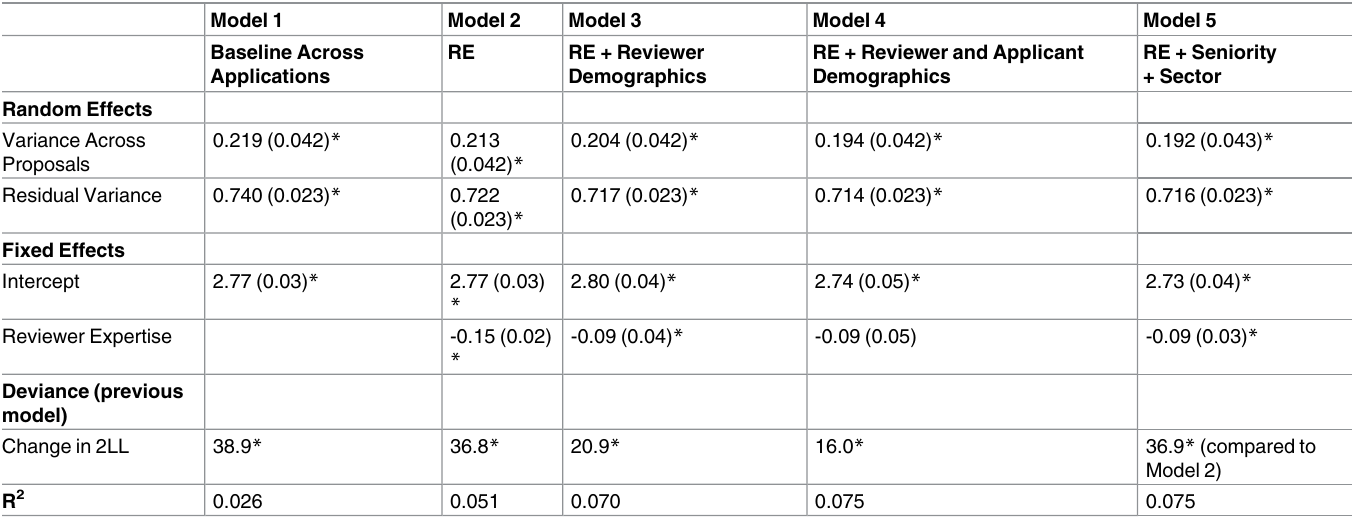
Table 3. Multi-level regression comparison of random-intercept